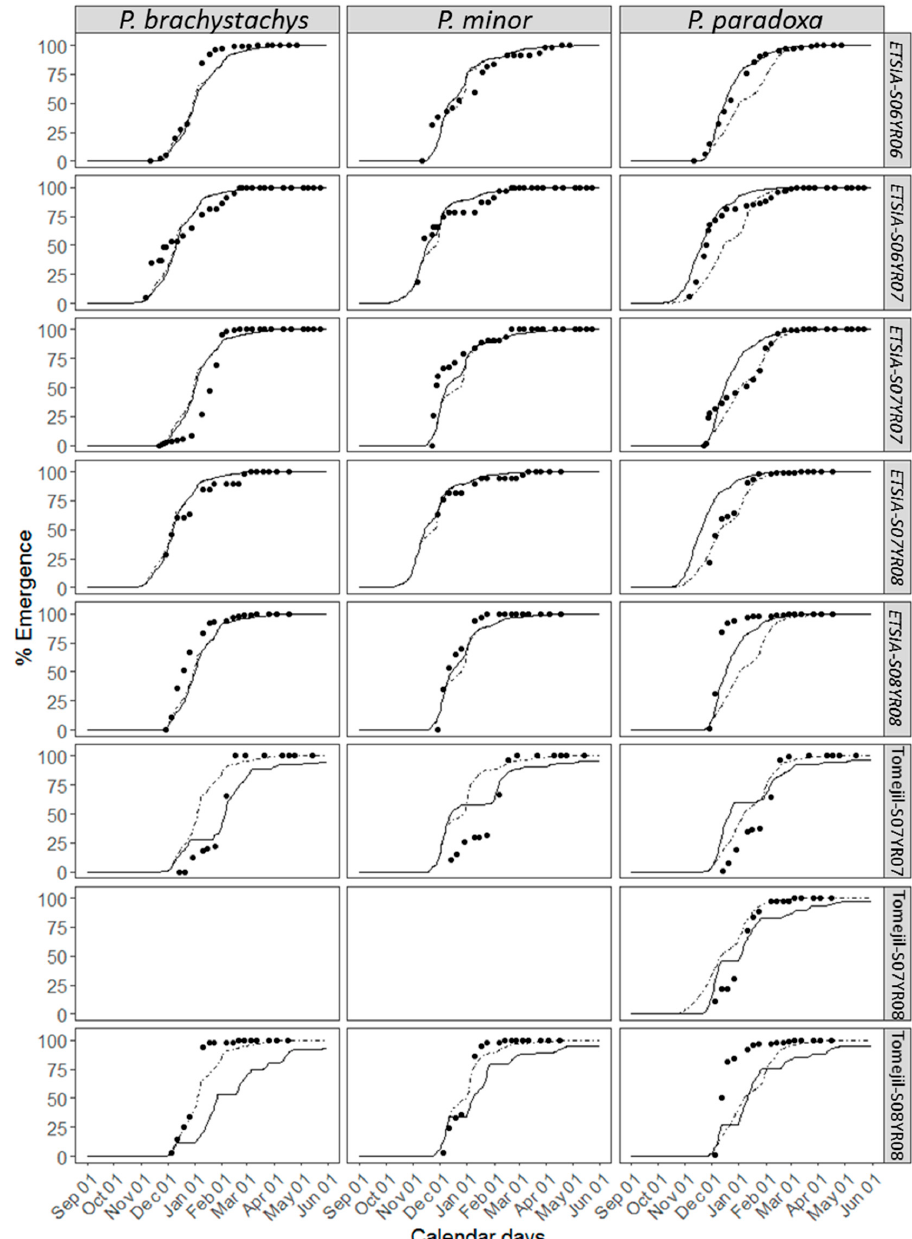
Figure 5. Predicted emergence of the three Phalaris species using thermal (dotted line) and hydrothermal (black line) non ‐ parametric model at each location and for the first and second seasons in each plot. The black dots show observed seedling emergence. The missing values of P. brachystachys and P. minor at Tomejil ‐ S07YR08 are due to the lack of enough seedling emergence to apply the models.